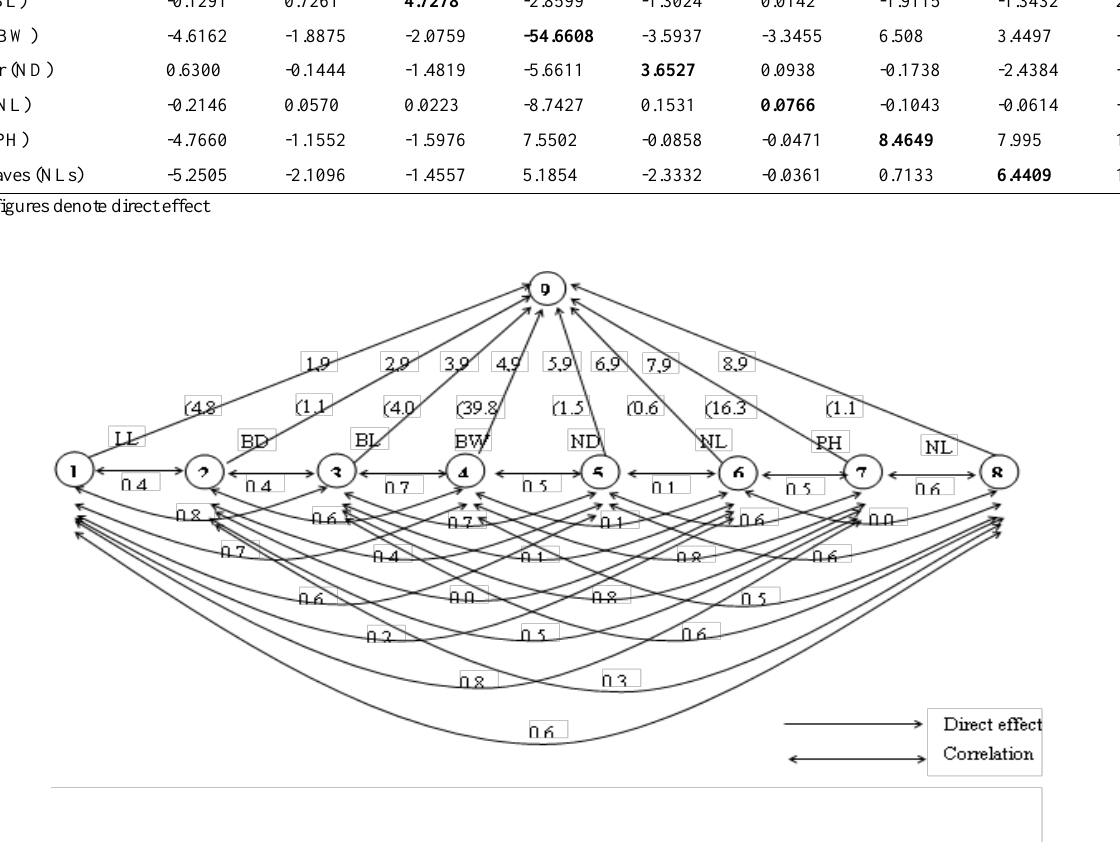
Figure 1 . Path diagram of different yield contributing factors on bulb yield at phenotypic level